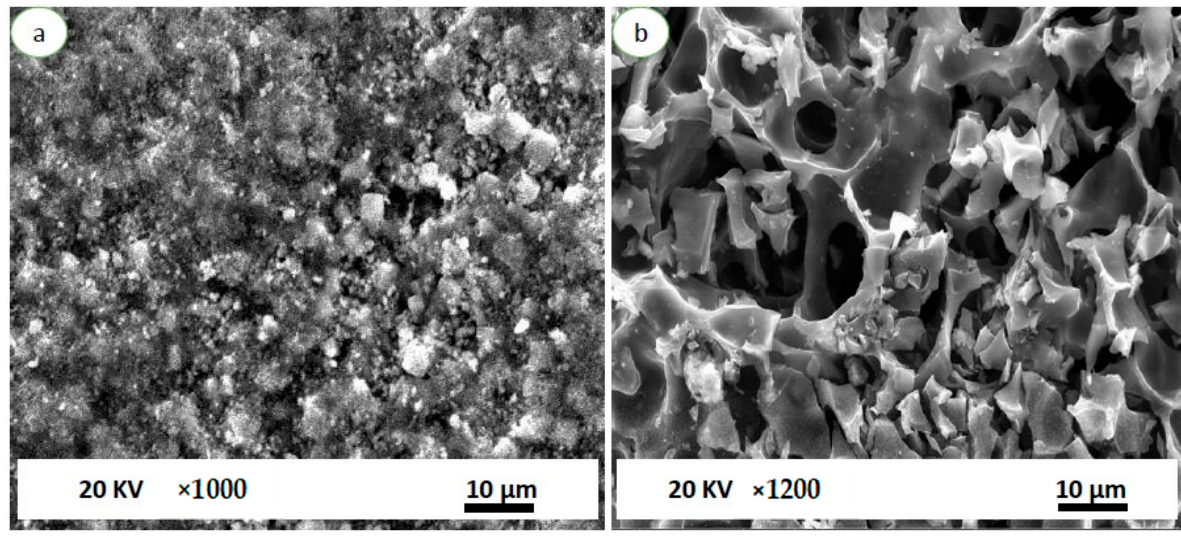
Figure 3. SEM images of ( a ) MS-3Å, and ( b ) AC-SY.